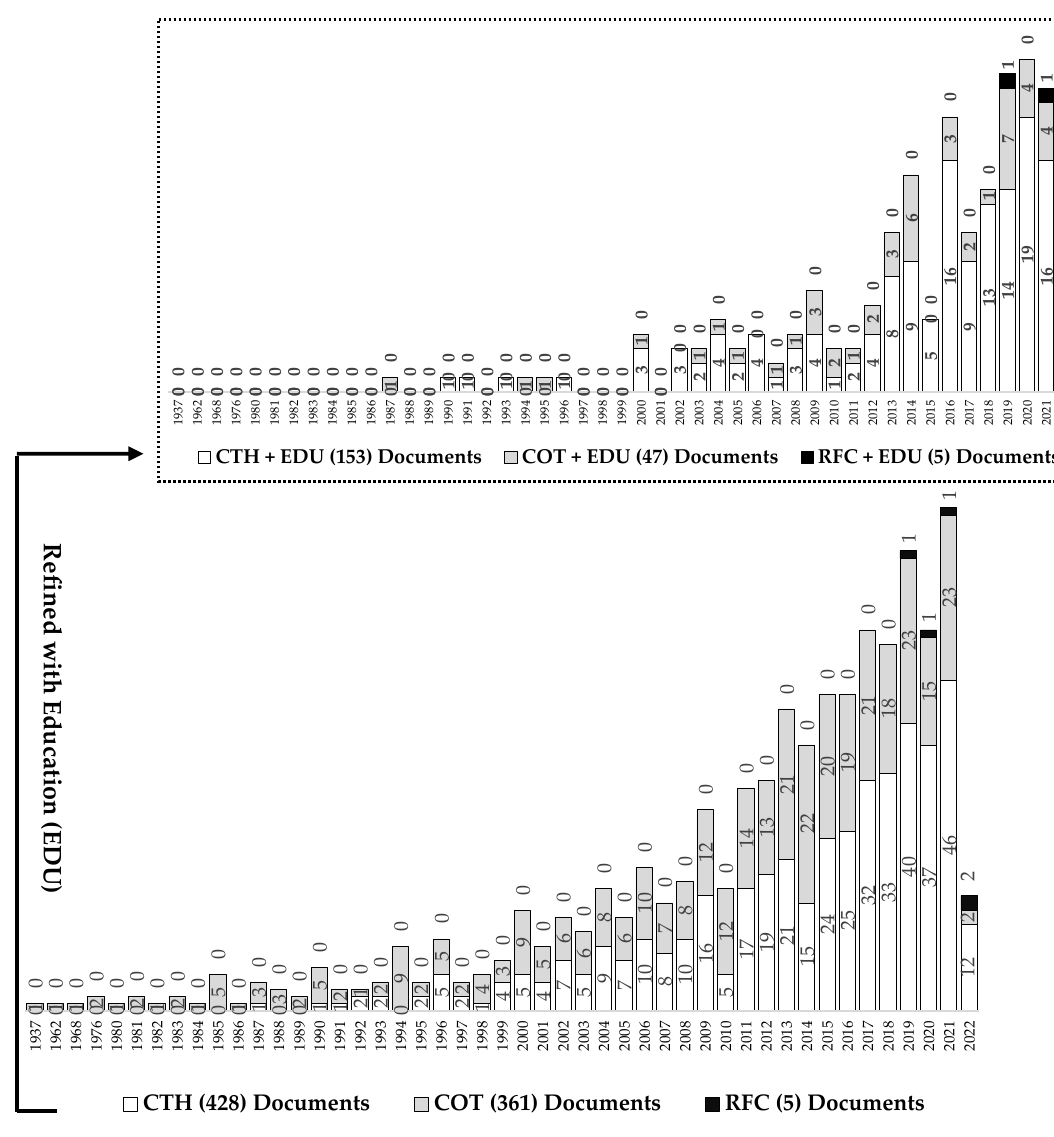
Figure 4. Historical behavior and variation of publications on complex thinking and education. Source: own elaboration based on Scopus (2022).